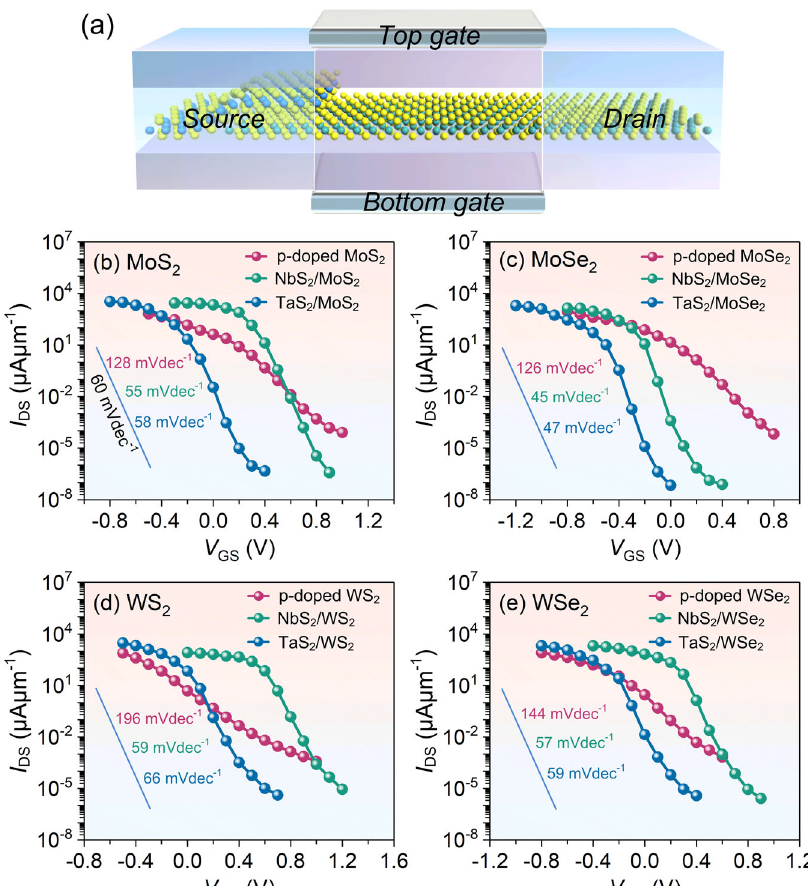
Fig. 2 The schematic view and transfer I-V curves of top contact CM-FETs. a The schematic view of top contact MS 2 /TMDs CM-FET. b – e I-V curves of CM-FETs and p-doped TMD MOSFETs. SS of each I-V curve is labelled in ( b – e ). The blue lines labelled in ( b – e ) represent the SS of 60 mVdec − 1